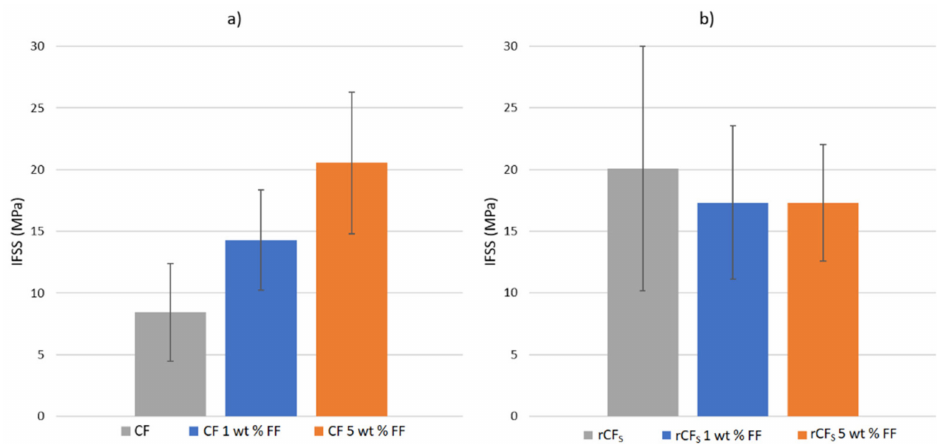
Figure 3. IFSS test results for ( a ) pristine CF and PP and ( b ) recycled rCF s and